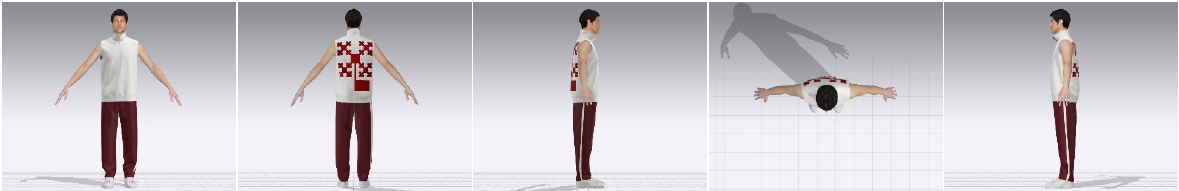
Figure 7. Α third-order Minkowski fractal antenna integrated into a women’s bomber jacket.